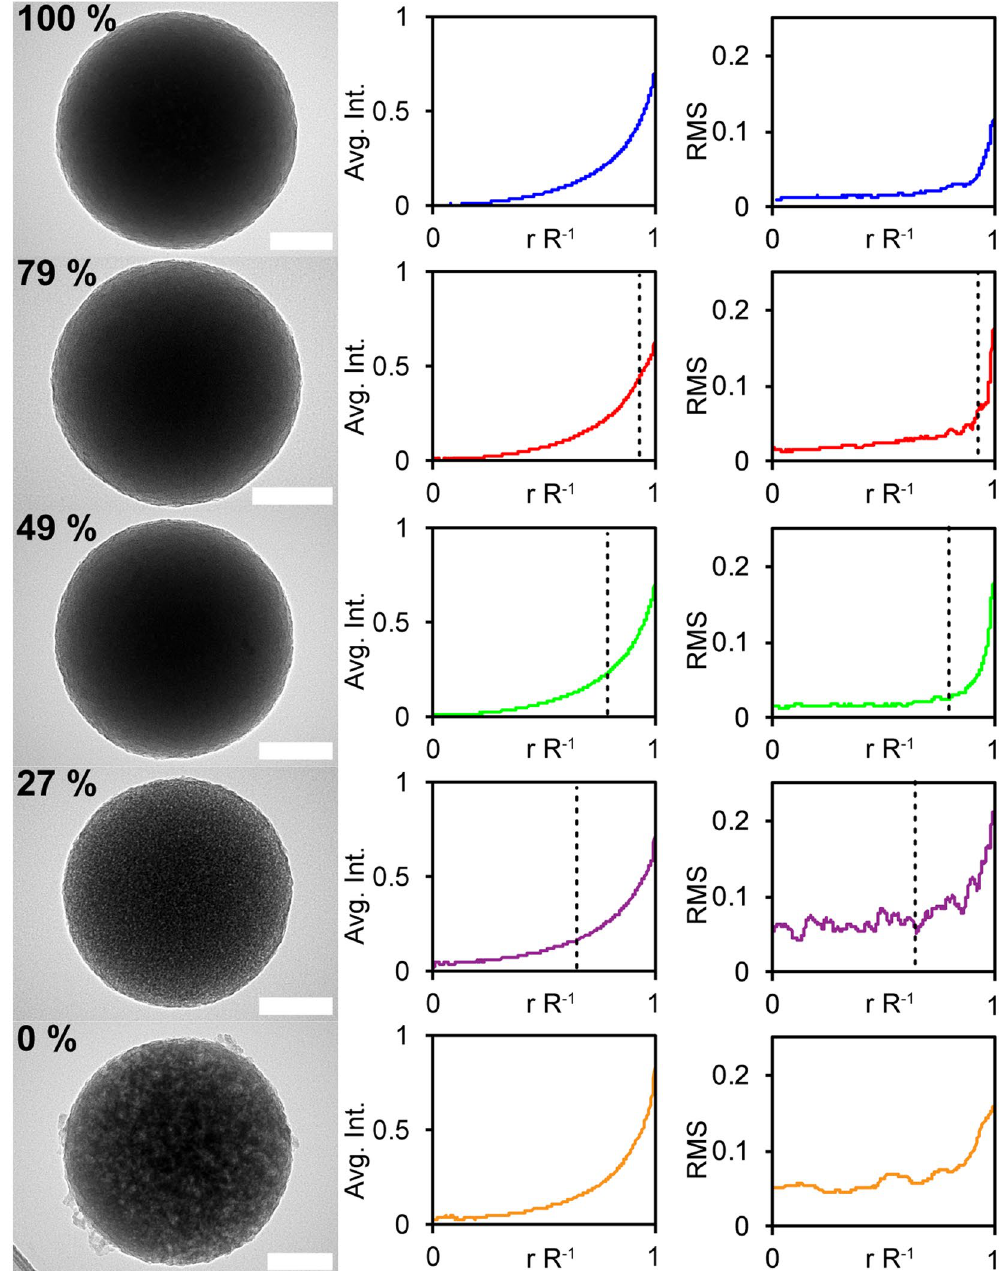
Figure 5. Particle porosity micrograph appearance is directly related to the proportion of drug released. Representative TEM micrographs of 100% through 0% loaded OCT-MSNs are shown on the left (scale bars are 100 nm). Normalized average radial intensity and normalized radial intensity RMS error (N = 7) is plotted beside each representative micrograph with the theoretical unextracted radius r’ marked by a dotted